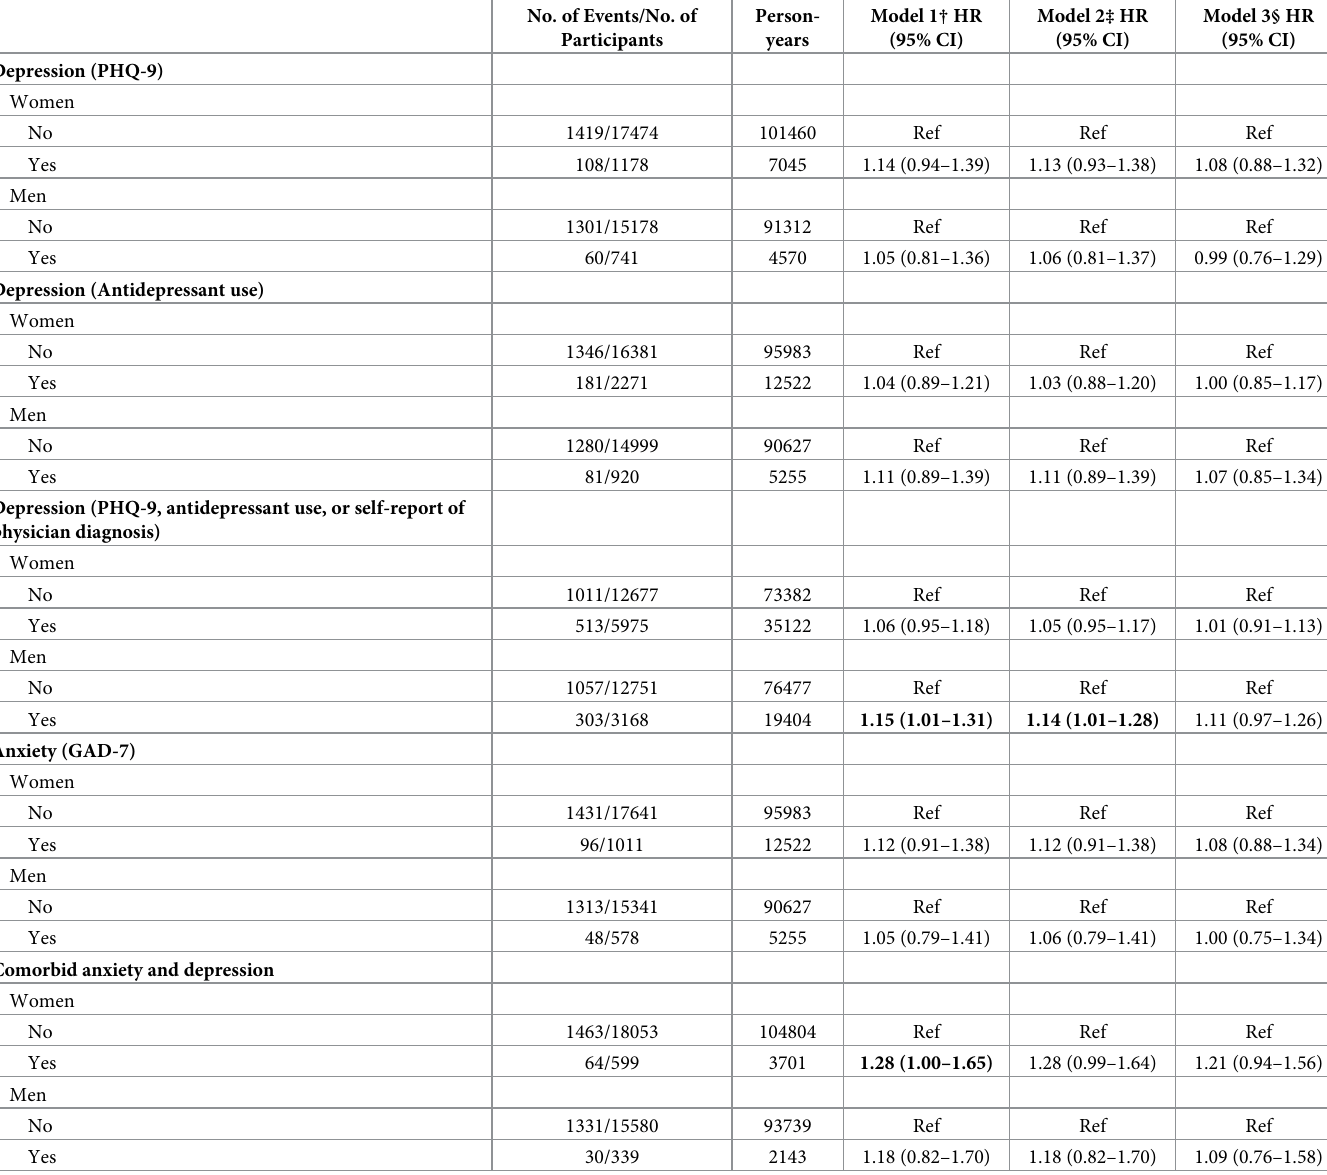
Table 4. Hazard ratios between mental health disorders and subsequent diagnosis of all cancers, stratified by sex.